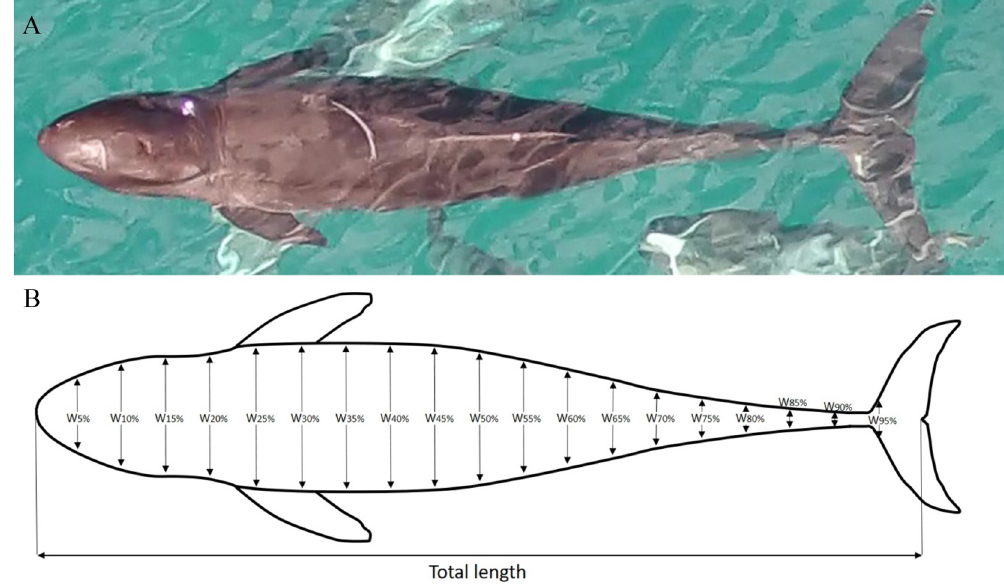
Figure 5. Example of an ( A ) aerial photograph taken from an unoccupied aerial system showing required body orientation at the surface to be used in analysis and ( B ) diagram noting the positions used to calculated total length and the 0–90% body volume. The diagram was made using Microsoft PowerPoint 2010 <https:// www. micro soft. com/ en- us/ micro soft- 365/ power